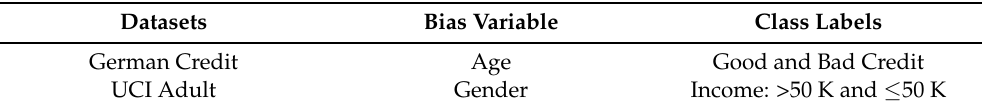
Table 1. Description of German Credit and Adult